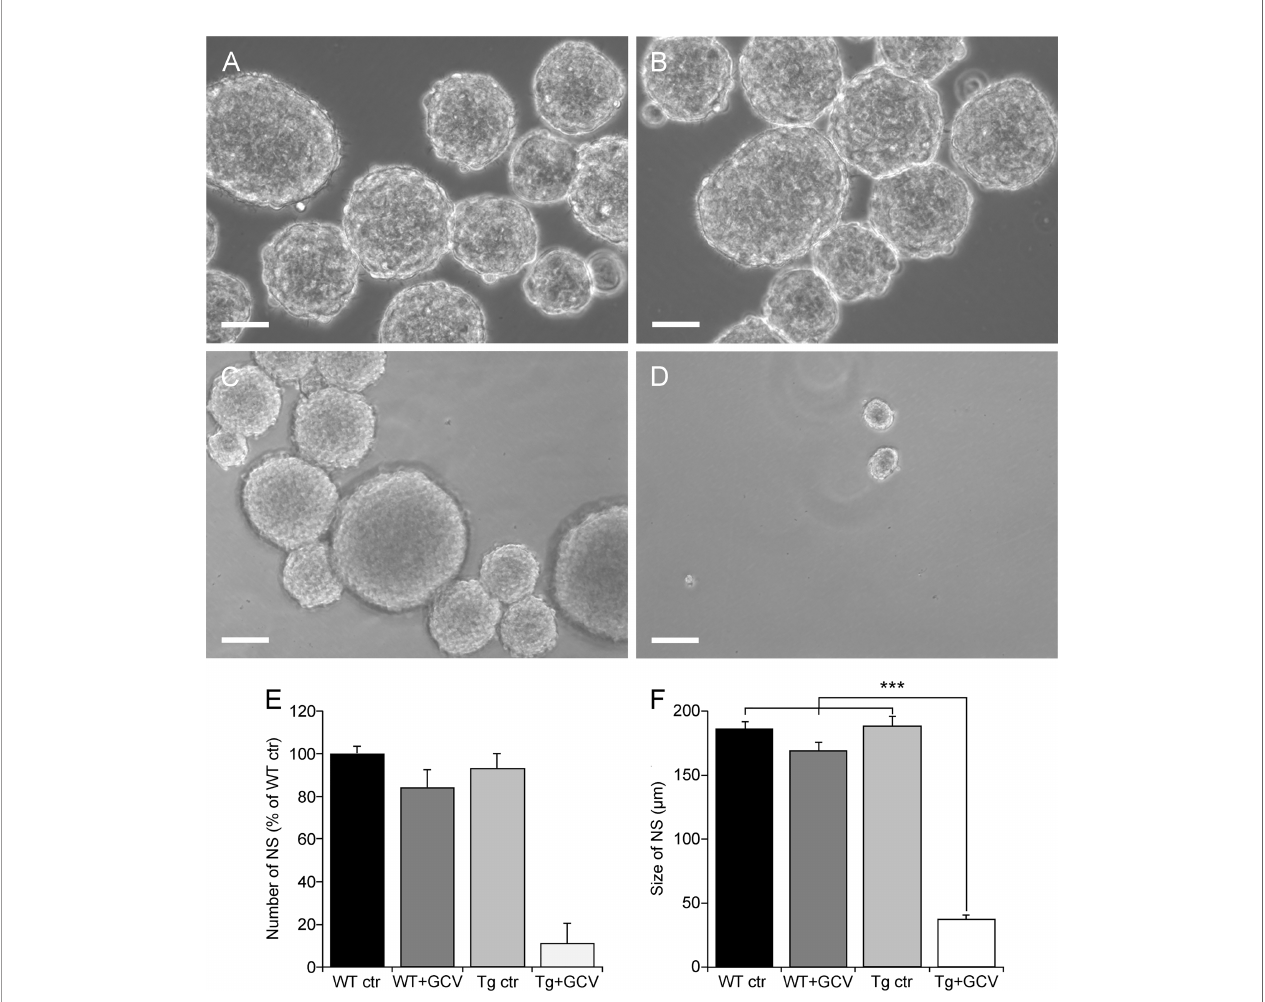
FIGURE 2 | GFAP-expressing cells are the predominant source of proliferative cells within the hypothalamus. Representative images of fl oating hypothalamic tertiary neurospheres (NS) derived from wild type mice (WT ctr; A ), wild type mice receiving a ganciclovir treatment (WT+GCV; B ), GFAP-Tk Tg mice (Tg ctr; C ) and GFAP- Tk Tg mice treated with an i.c.v. ganciclovir injection (Tg+ GCV; D ). Scale bar, 100 µm. Number (E) and size (F) of hypothalamic neurospheres after a 2-week culture period in presence of GCV. Data are expressed as the mean ± SEM, WT n=2 and Tg mice n>3 for each group, n=3 experiments.